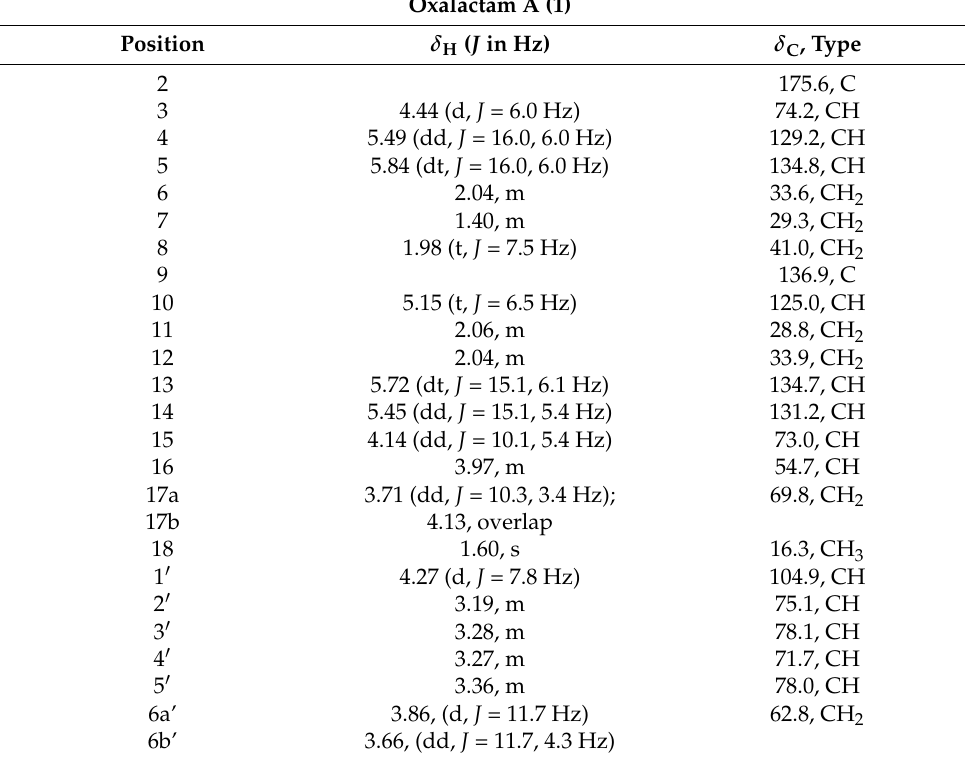
Table 1. NMR Spectroscopic Data (500 MHz, CD 3 OD) for Oxalactam A ( 1 ).